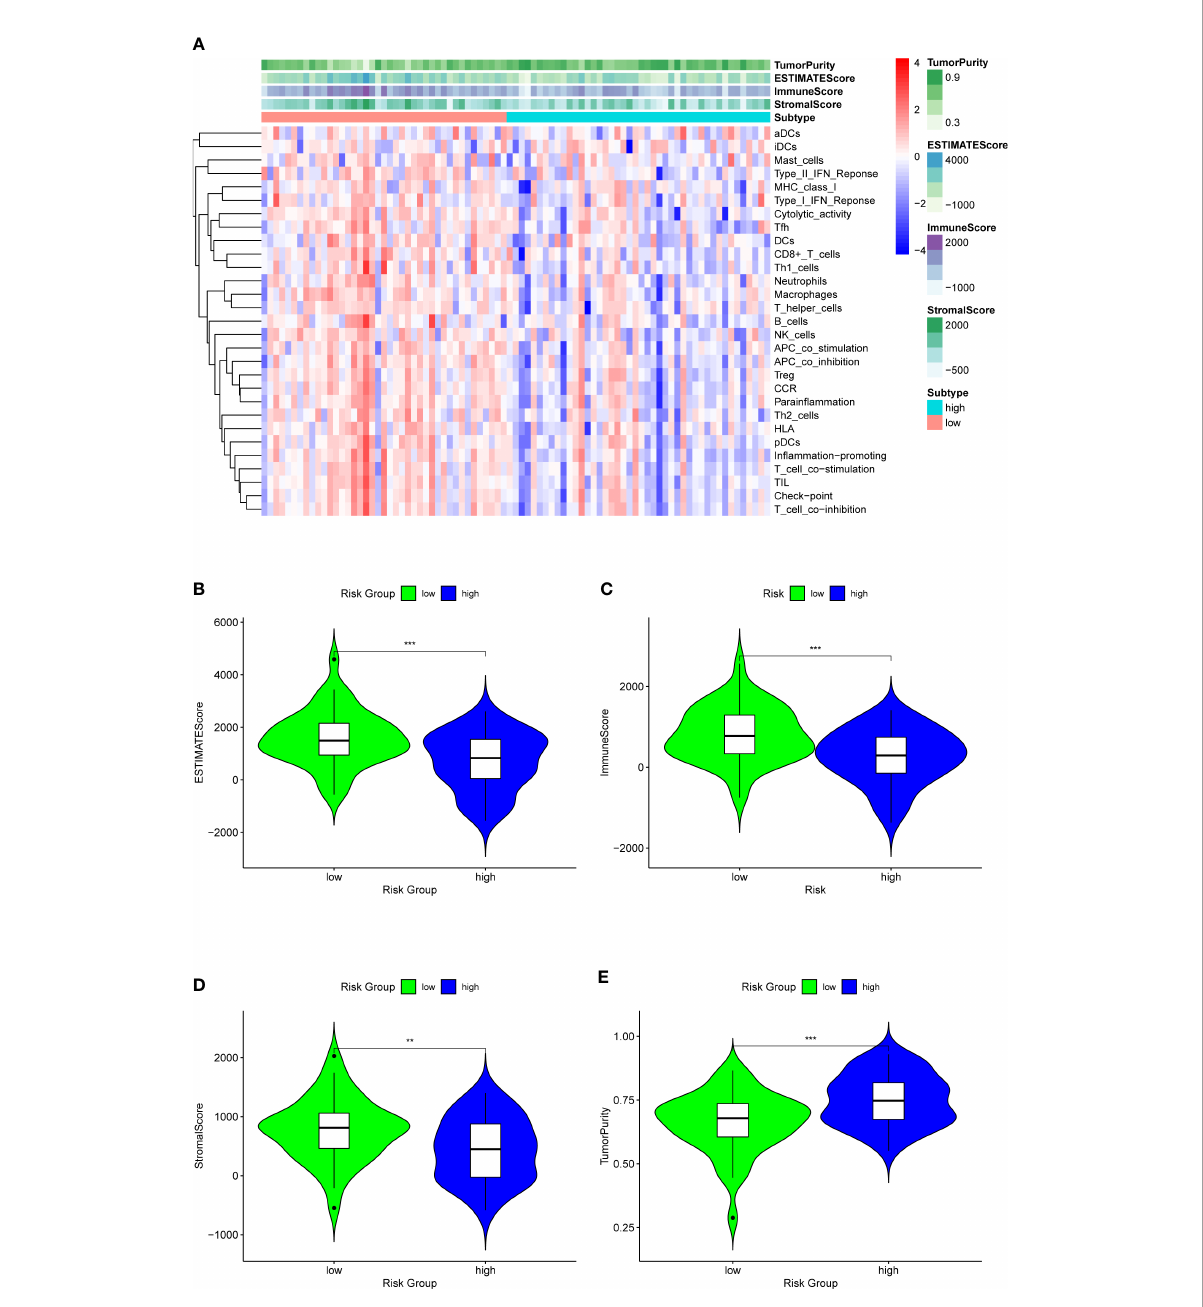
FIGURE 11 ESTIMATE analysis for the two groups to explore the immune in fi ltration. (A) A heatmap of ESTIMATE analysis of the two risk groups. (B) A violin plot of ESTIMATEScore in two risk groups, which shows a signi fi cant lower score in high-OS group. (C) A violin plot of ImmuneScore in two risk groups, which shows a signi fi cant lower score in high-OS group. (D) A violin plot of StromalScore in two risk groups, which shows a signi fi cant lower score in high-OS group. (E) A violin plot of TumorPurity in two risk groups, which shows a signi fi cant higher tumor purity in high-OS group. “ ** ” represented “ p<0.01 ” , “ *** ” represented “ p<0.001 ”